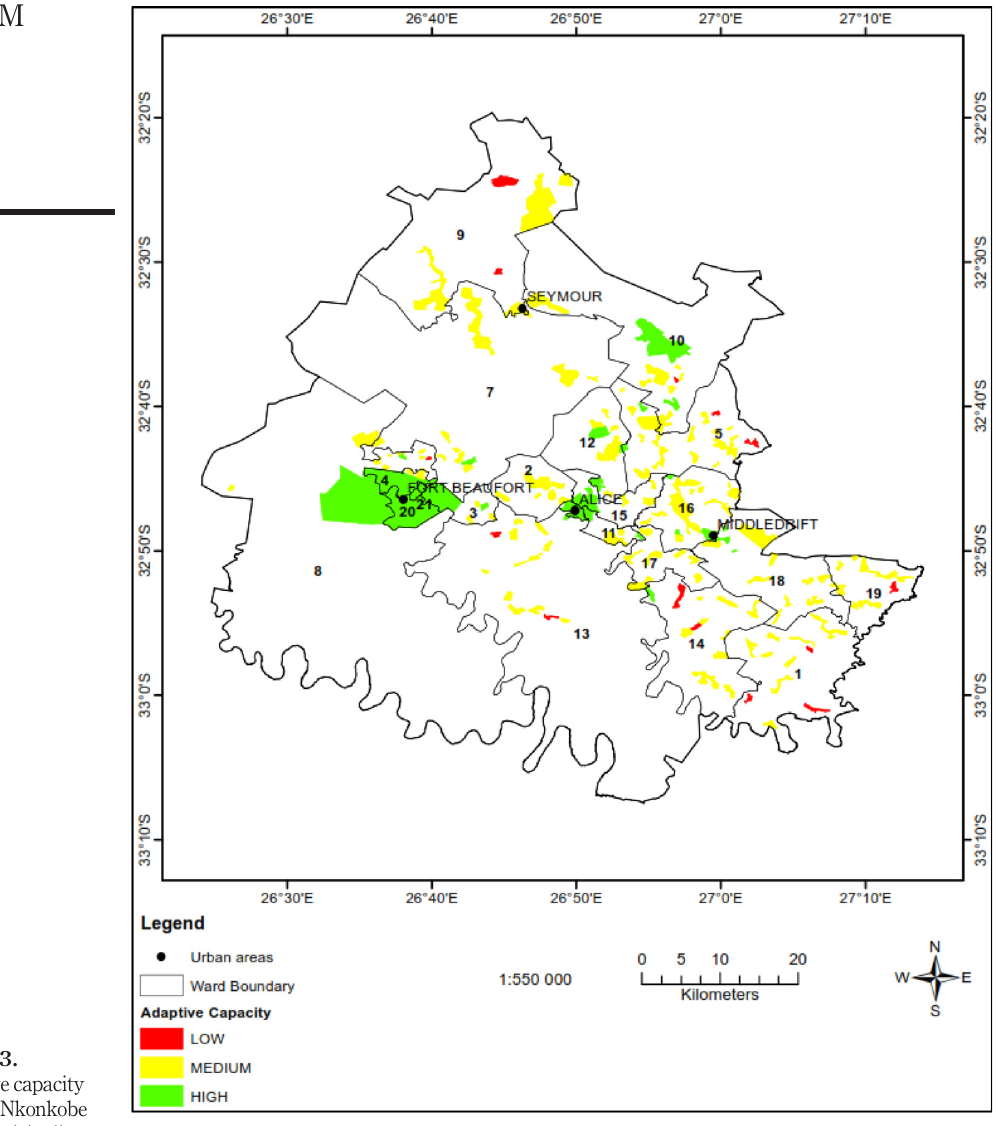
Figure 3. Adaptive